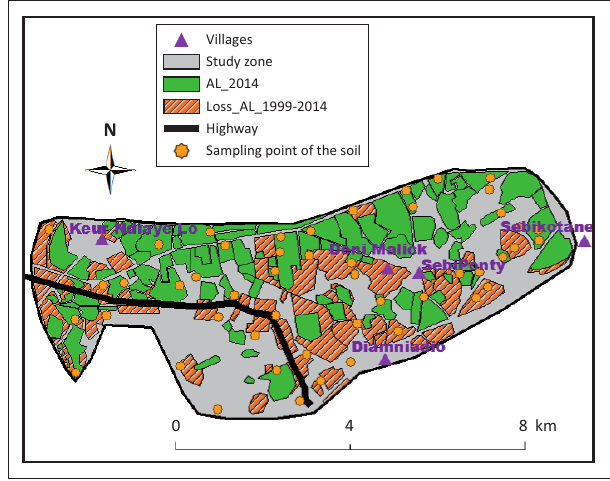
FIGURE 2: Dynamics of the agricultural land from 1999 to